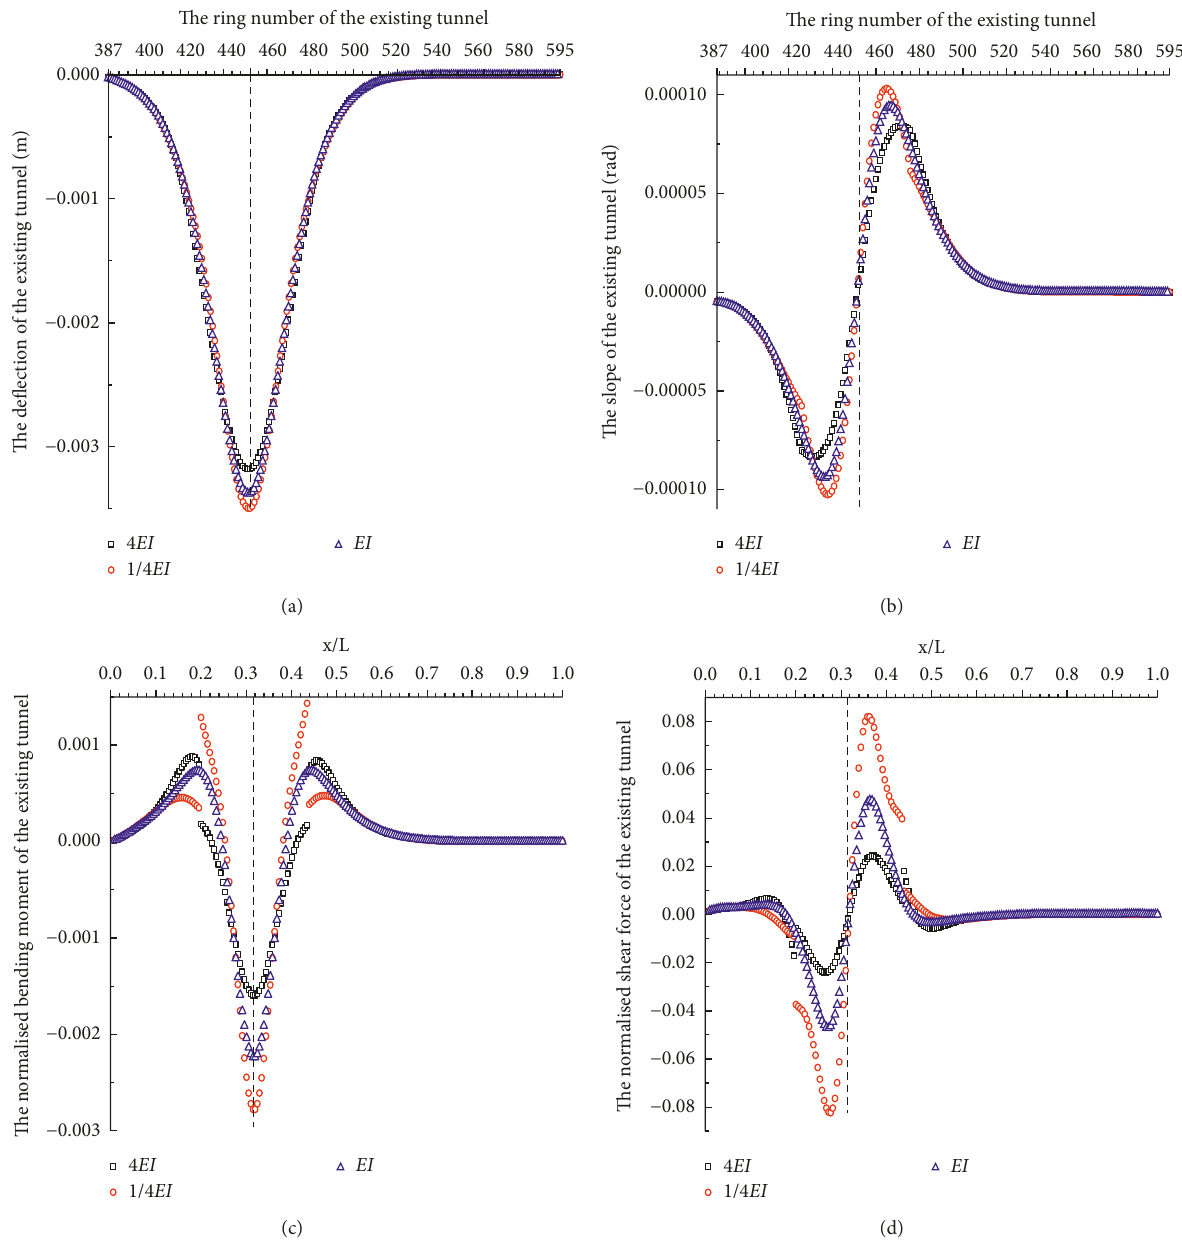
Figure 20: (a) The effects of different reinforcement stiffness on the deflection of the existing tunnel. (b) The effects of different re- inforcement stiffness on the slope of the existing tunnel. (c) The effects of different reinforcement stiffness on the normalized moment of the existing tunnel. (d) The effects of different reinforcement stiffness on the normalized shear force of the existing